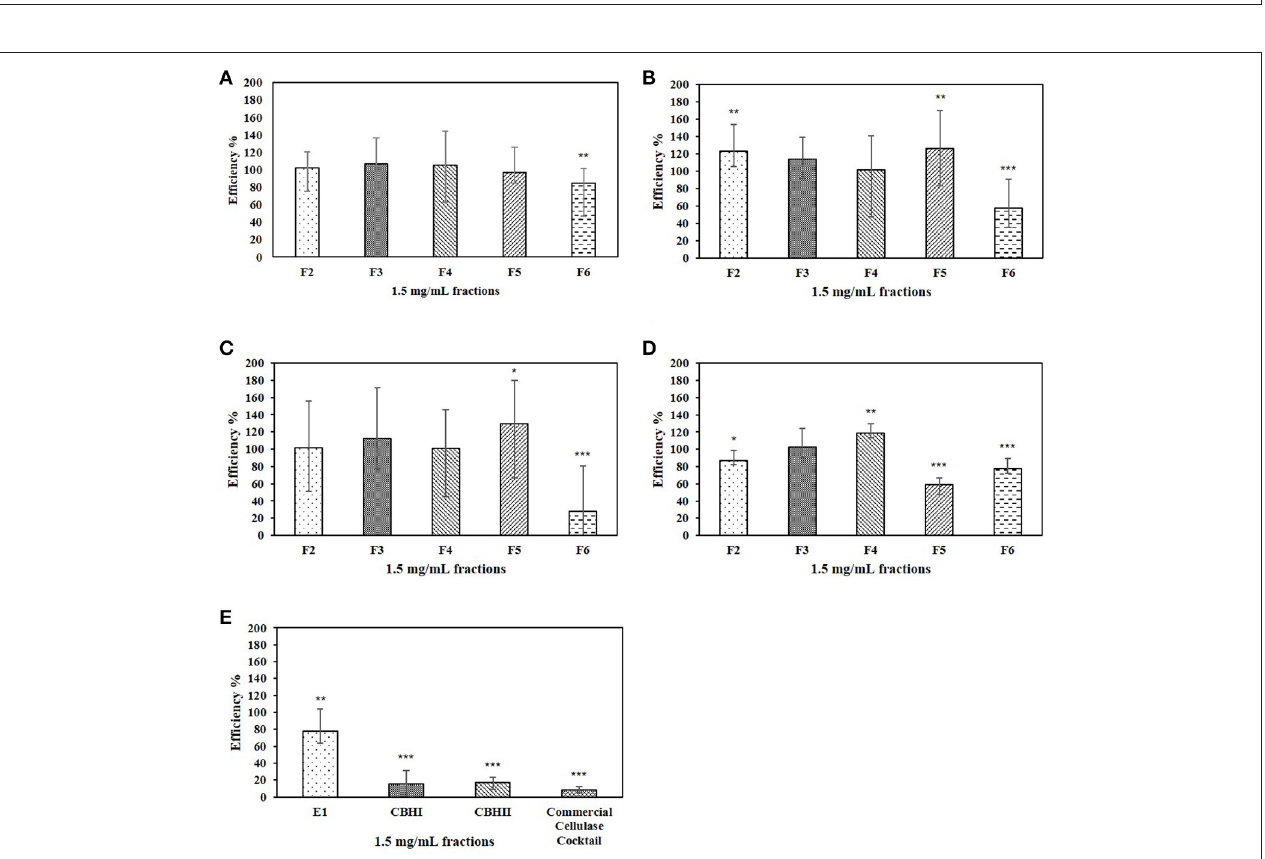
FIGURE 3 | (A–D) Effects of CPC fractionated pinewood HW pre-hydrolyzate with a final concentration of 1.5 mg/mL on the enzymatic efficiency of E1, CBHI, CBHII and commercial cellulase cocktail during the cellulose-DNS assay; (E) Effect of 10% butanol solvent on the enzymatic efficiency of each cellulolytic enzyme. Symbol * represents the level of significance according to the double tailed t -test. Standard error bars were used to represent the deviation.